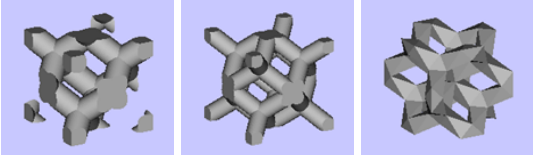
Figure 1. Basic element cells for creation of the test specimens.